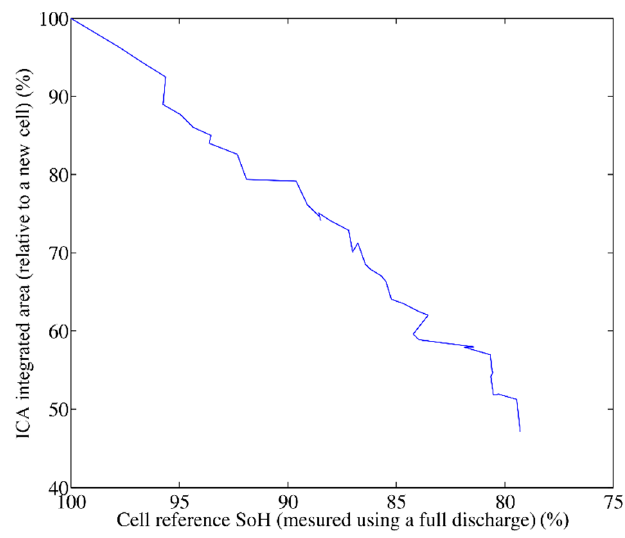
Figure 5. Integrated area function of the cell SoH.